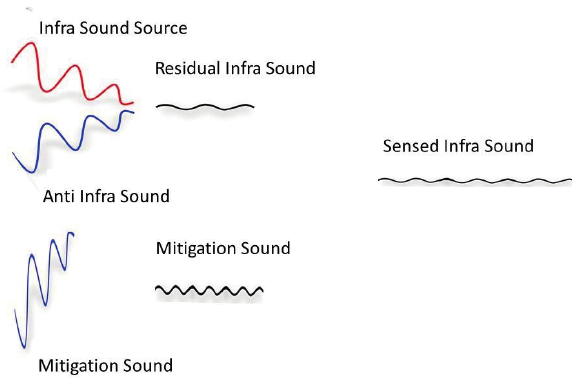
Fig. 3: Principle of the active infra-sound cancellation and mitiga- tion device. The amplitudes of the residual infra-sound components are reduced. Small amplitude mitigation sounds further reduce their sensing by humans.